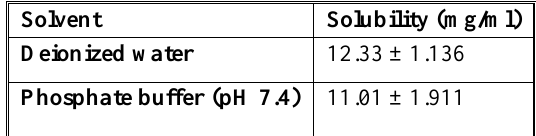
Table (3) Solubility of rebamipide in presence of